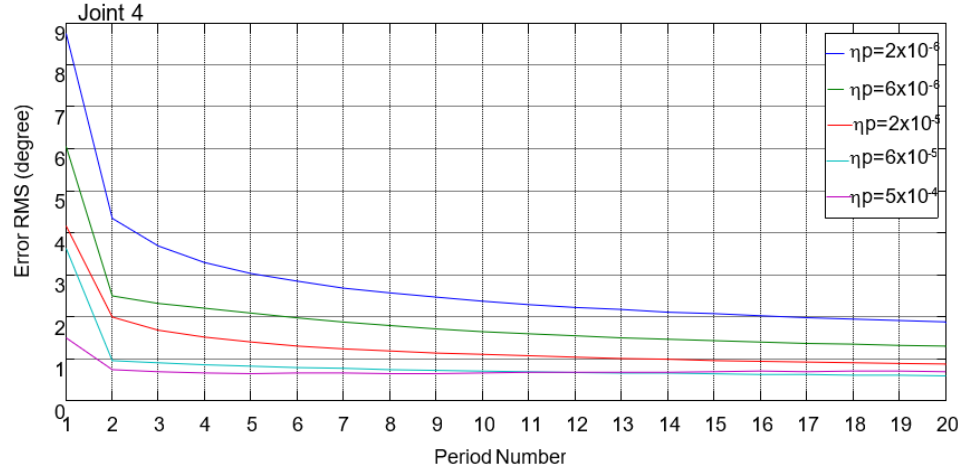
Figure 13. RMSE convergence curves for different convergence factors in the tracking experiment.